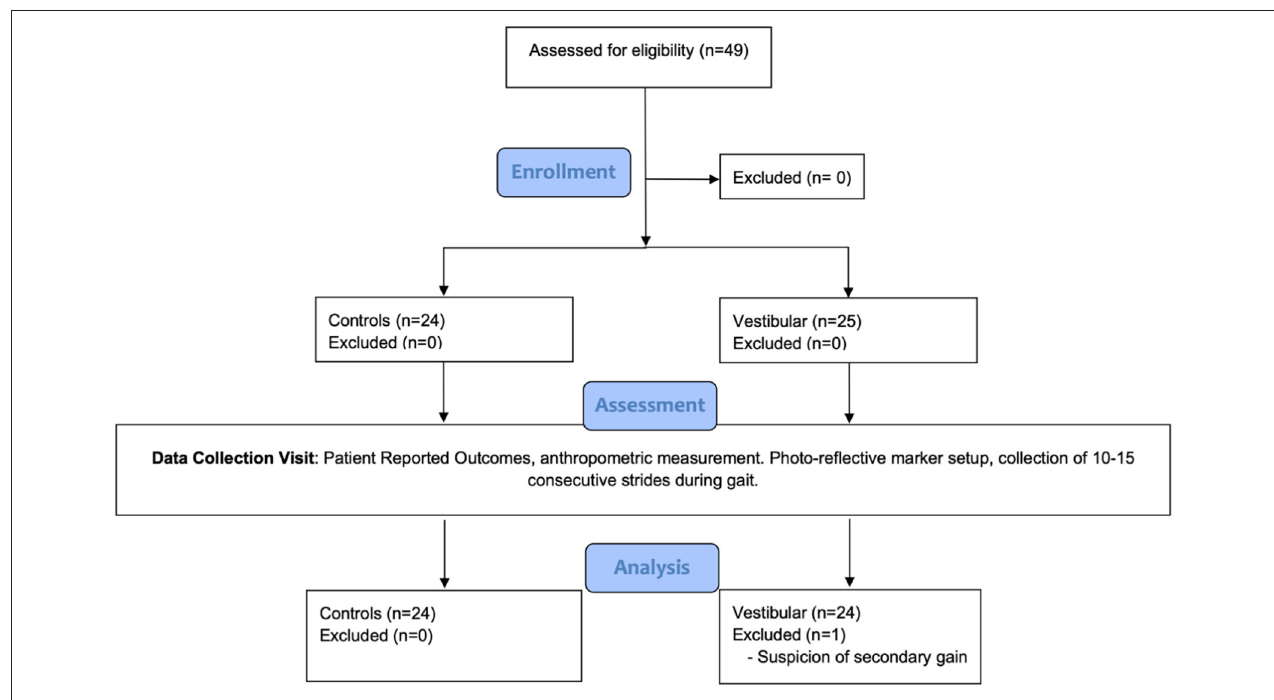
FIGURE 1 | Study flow